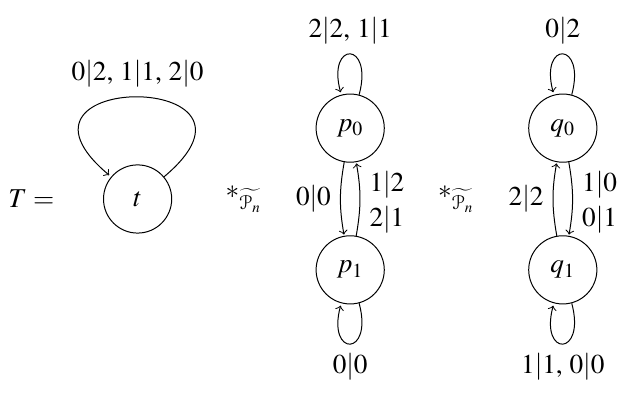
Figure 6: Decomposing an element of H 3 as a product of